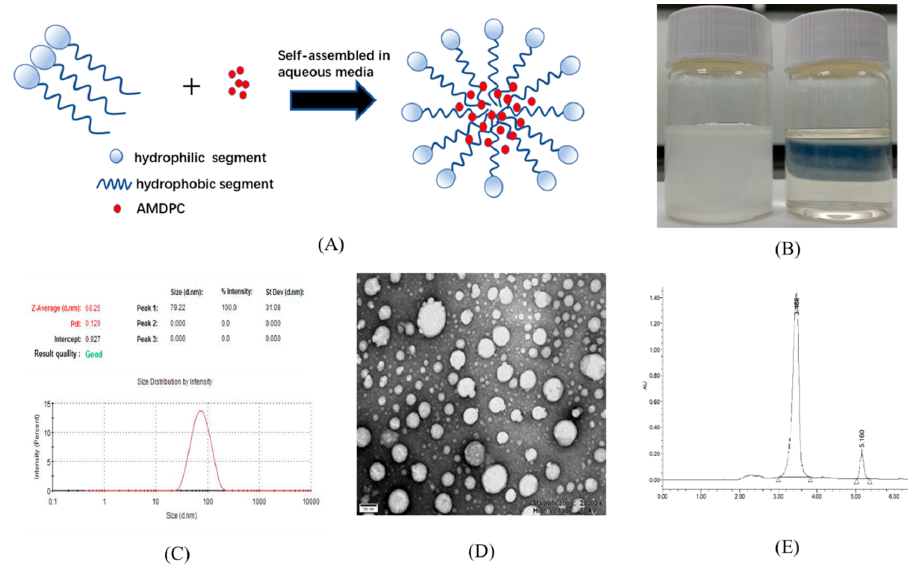
Figure 2. Characterization of 6-amino-4-(2-hydroxyphenyl)-3-methyl-1,4-dihydropyrano[2,3-c]pyrazole-5-carbonitrile (AMDPC)-loaded PEG-PLGA nanoparticles (mPEG-PLGA/AMDPC). ( A ) Schematic diagram for the self-assembled and AMDPC loading mechanism. ( B ) Particle size distribution and dispersion of 50 µ g/mL free AMDPC in water (left) and AMDPC-NP (right). ( C ) Dynamic light scattering size measurement of AMDPC-NP. ( D ) Transmission electron micrograph (TEM) image of